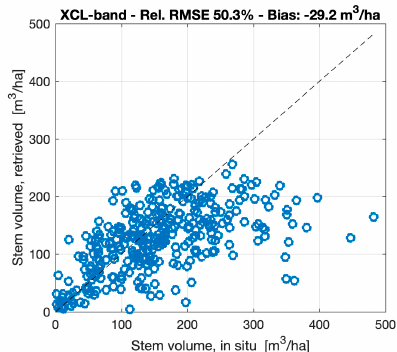
Figure 14. Scatter plot of measured and retrieved stem volume at Krycklan for a combination of all estimates obtained at X-, C-, and L-band.